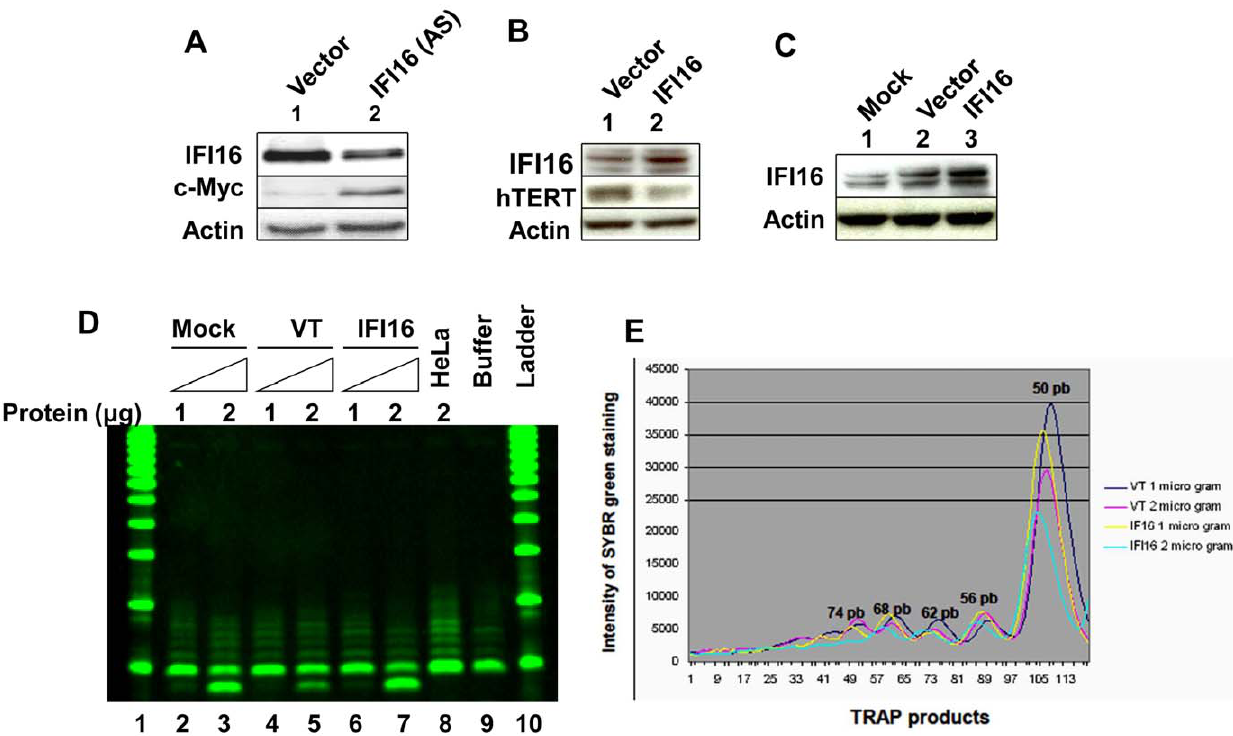
Figure 4. Increased levels of IFI16 protein in WI-38 cells reduce hTERT levels and inhibit telomerase activity. ( A ) Total protein extracts prepared fromWI-38cellstransfectedwithcontrolsiRNA(lane1)orIFI16siRNARNA(lane2)weresubjectedtoimmunoblottingusingantibodiesspecifictotheindicated proteins. ( B ) Total protein extracts prepared from WI-38 cells, either transfected with control (pCMV) vector (lane 1) or pCMV-IFI16 plasmid (lane 2), were subjectedtoimmunoblottingusingantibodiesspecifictotheindicatedproteins.( C )TotalproteinextractspreparedfromWI-38cellstreatedwithlipofectamine (mock, lane 1), transfected with control (pCMV) vector (lane 2) or pCMV-IFI16 plasmid (lane 3) were subjected to immunoblotting using antibodies specific to the indicated proteins. ( D ) Extracts containing the indicated amounts ( m g) of proteins from mock transfected (lanes 2 and 3)CMV transfected (lanes 4 and 5), or pCMV-IFI16 transfected (lanes 6 and 7) young WI-38 cells were subjected to TRAPeze assays to detect the telomerase activity. As controls, extracts from HeLa cells (lane 8) or buffer alone (lane 9) were also included in the assay. The reaction products were subjected to native polyacrylamide gel electrophoresis along